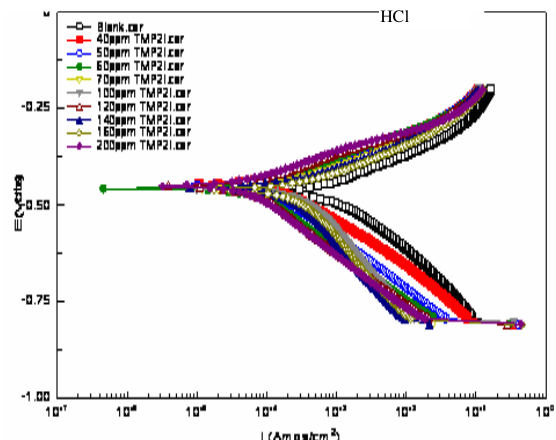
SO and HCl 2 4 SO 2 4